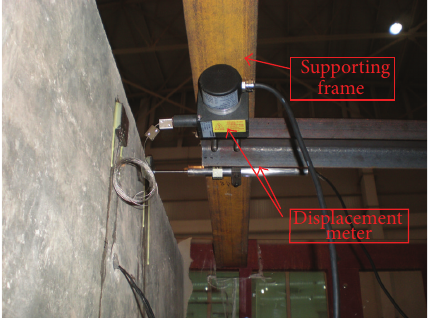
Figure 5: Displacement sensor installation diagram.